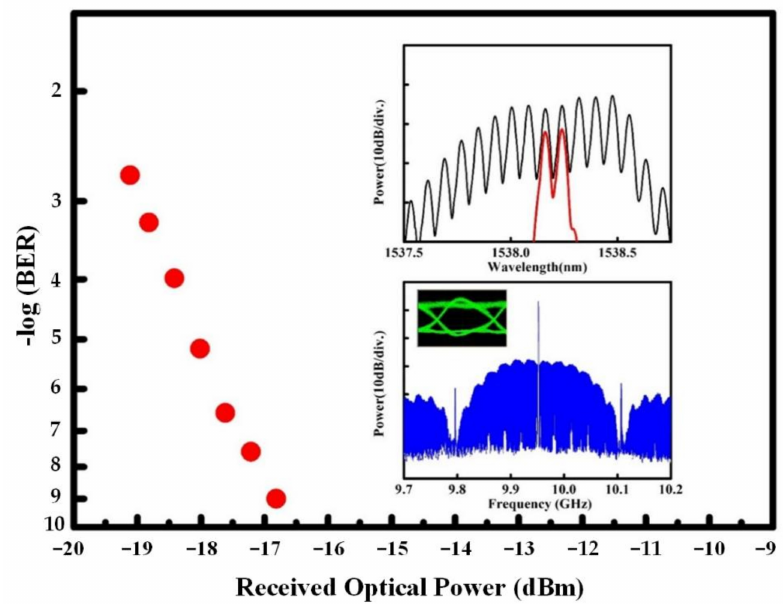
Figure 9. The measured BER, eye diagram, and electrical and optical spectrum on two selected